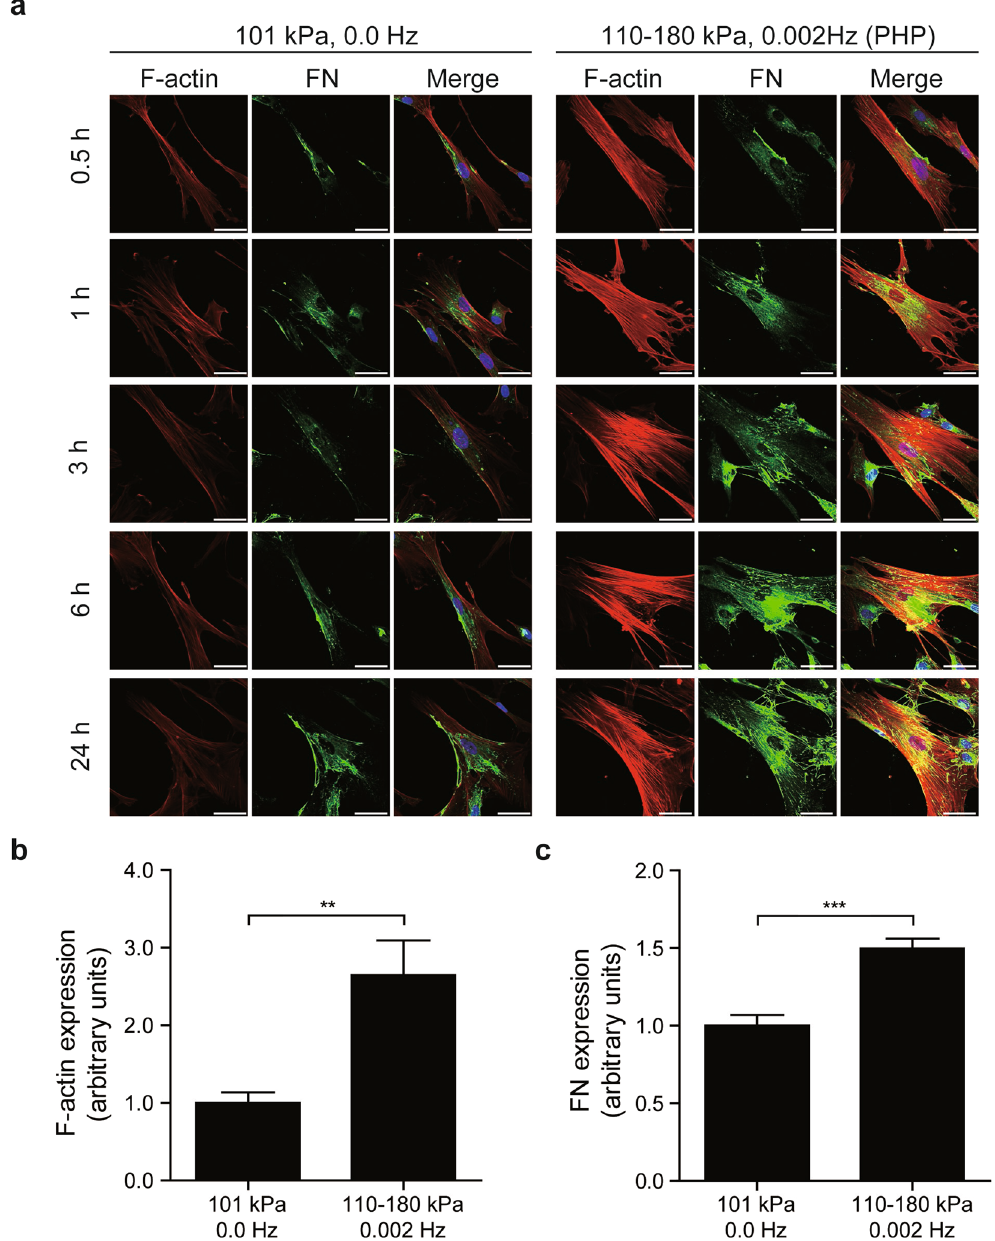
Figure 2. Time-dependent effect of PHP pressurization on stress-fiber formation and FN fibrillogenesis. ( a ) Representative images of immunocytochemistry of hUASMCs exposed to PHP (110–180 kPa, 0.002 Hz) up to 24 h. Cells were stained for F-actin and FN to visualize stress-fiber formation and FN fibrillogenesis. Scale bars: 50 μ m. ( b and c ) Quantification of intensity of F-actin and FN of cells exposed to the pressure for 24 h, respectively. n = 11–12, ** p < 0.01; *** p < 0.001 vs. 101 kPa, 0.0 Hz (atmospheric pressure). Values are shown as the mean ± standard error of the mean (SEM) of independent experiments. Data were analyzed using two- tailed unpaired Student’s t